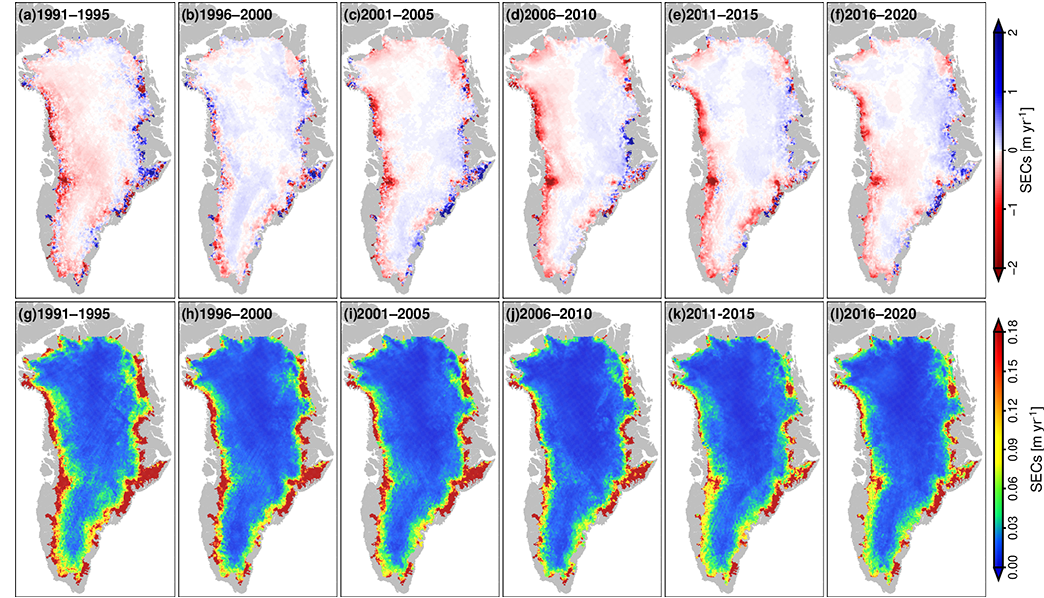
Figure 6. Maps of long-term SECs and their uncertainties from the combined elevation time series over the periods of (a, g) 1991–1995, (b, h) 1996–2000, (c, i) 2001–2005, (d, j) 2006–2010, (e, k) 2011–2015, and (f, l)